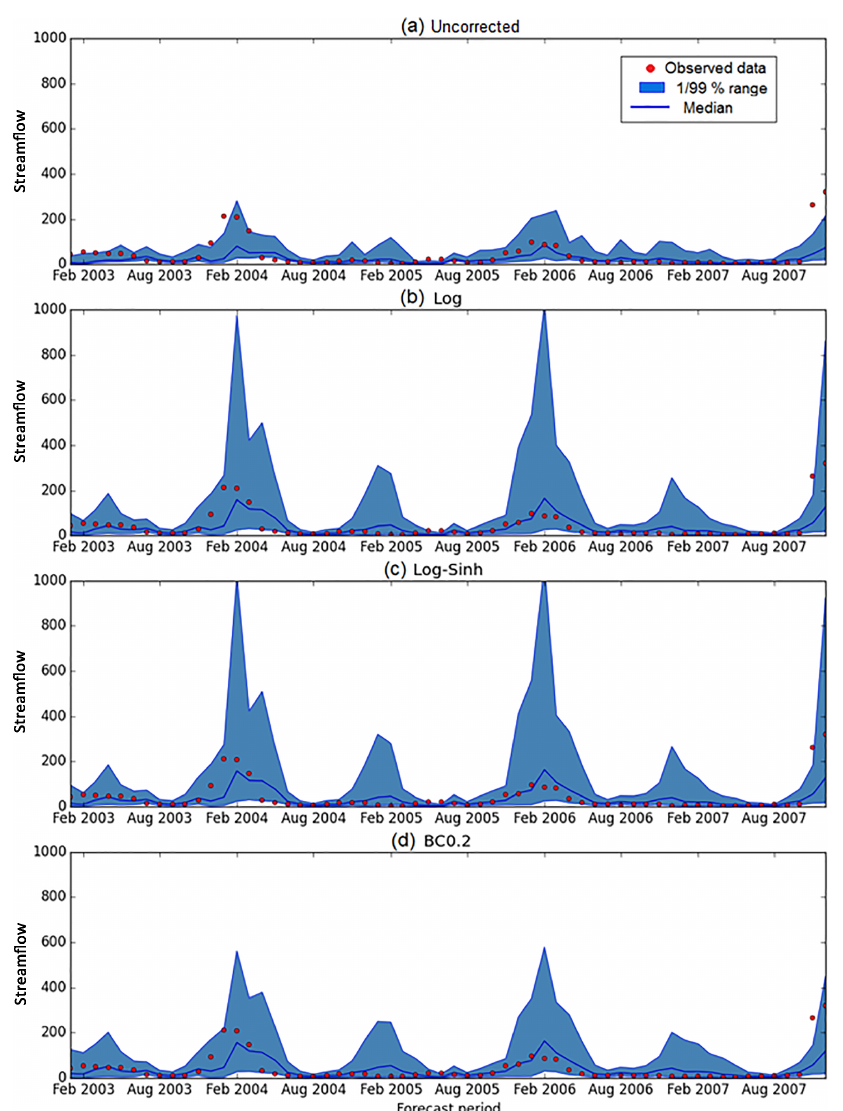
Figure 8. Seasonal streamflow forecast time series (blue line) and observations (red dots) at Dieckmans Bridge catchment (site id: 145010A). The shaded area shows the 99% prediction